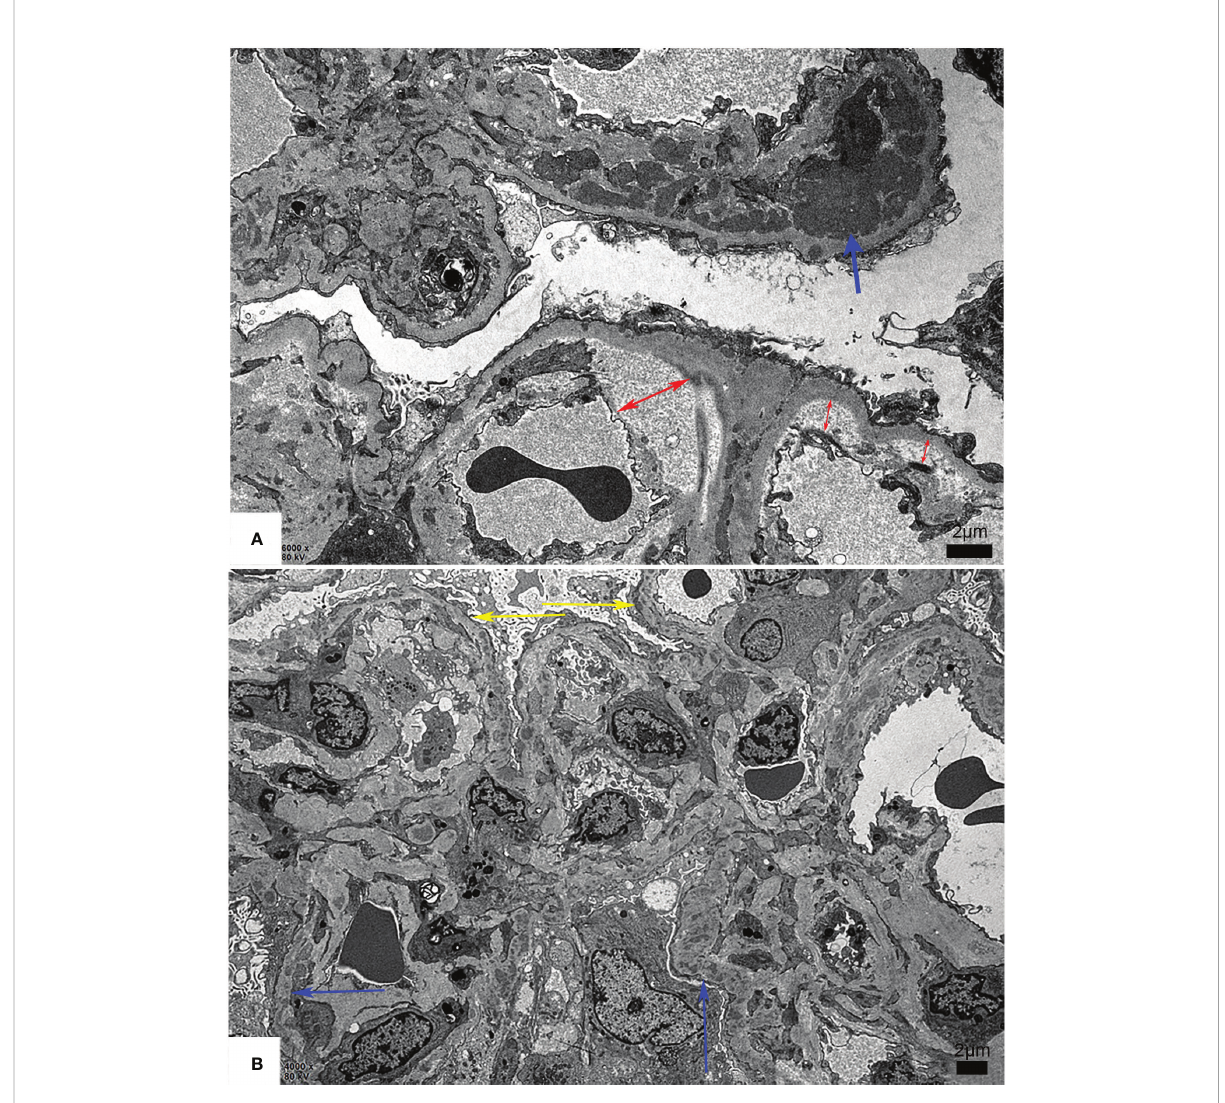
FIGURE 2 Representative electron microscopy changes of renal thrombotic microangiopathy. (A) The dense deposition (blue arrow) and mild, moderate widening of the loose layer (red arrow) in the basement membrane. (B) The formation of the double track sign (yellow arrow) and dense deposition in the basement membrane (blue arrow). Scale bars represent 2 m